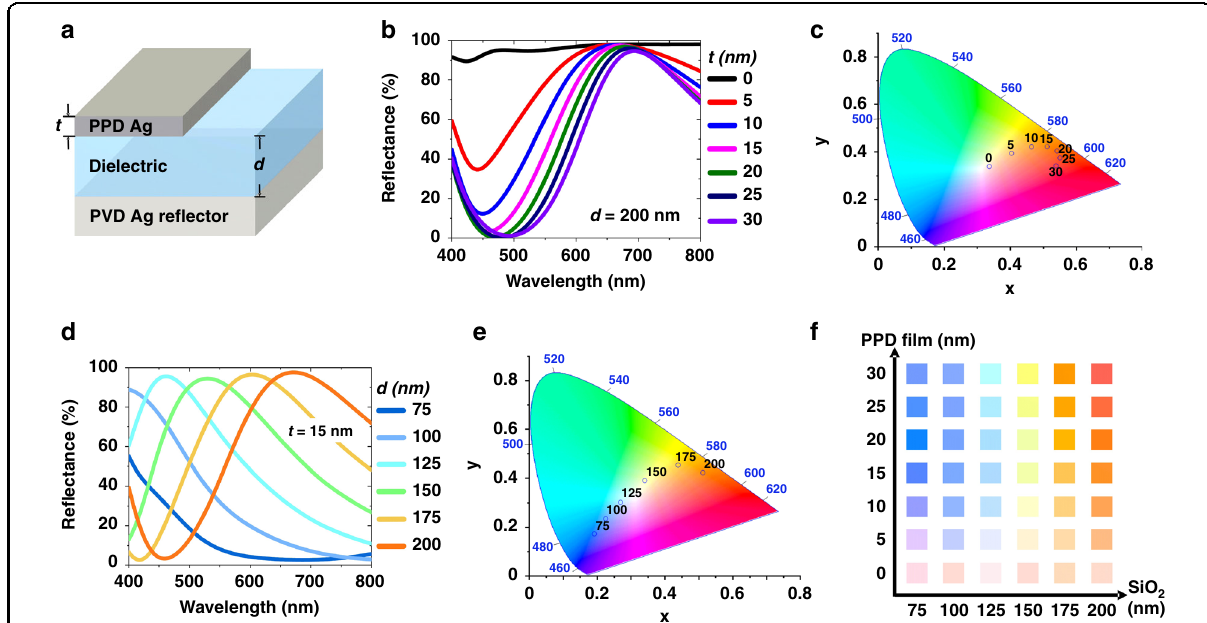
Fig. 3 FDTD simulated re fl ectance spectra for the design of structural colors. a Three-dimensional schematic of the FP cavity, with the top-layer PPD-printed thin fi lm thickness t and dielectric spacer thickness d as variables. b Re fl ectance spectra with variable t and fi xed d = 200 nm. c 1931 CIE color coordinates corresponding to ( b ). d Re fl ectance spectra for variable d and fi xed t = 15 nm. e CIE color coordinates corresponding to ( d ). f The color palettes are based on the simulated re fl ectance spectra with varying d and t